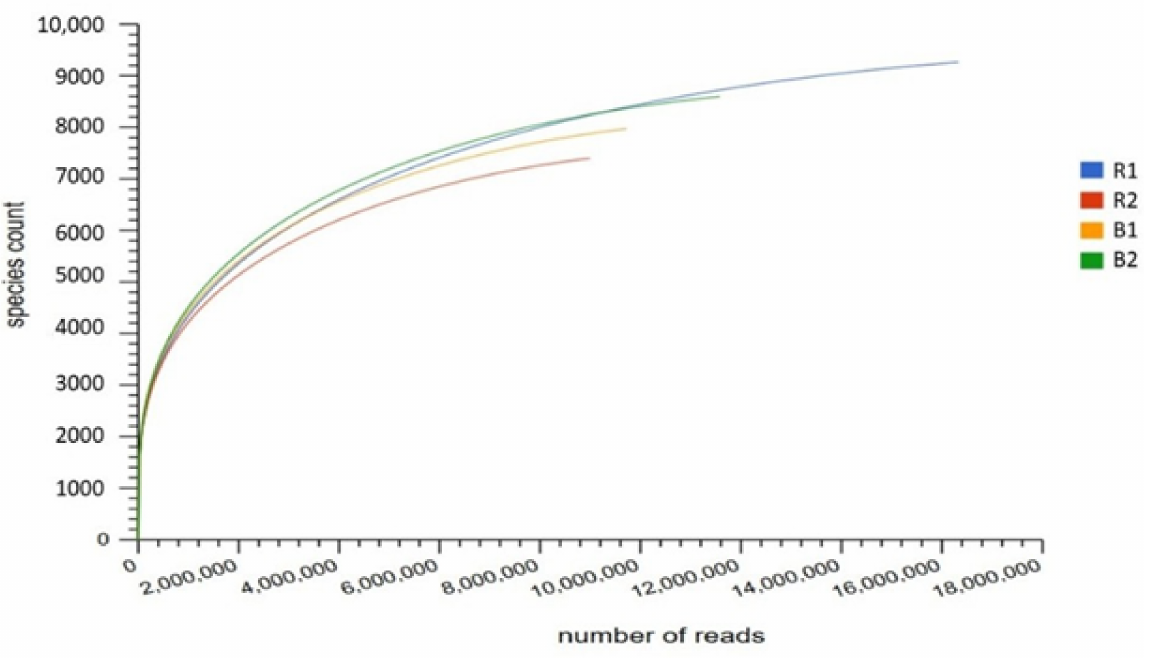
Figure 2. Rarefaction curve showing species richness in the sunflower rhizosphere and its bulk soil samples. The DNA sequencing from the four soil samples (R1, R2, B1, B2) using Illumina technology resulted in a bp count for R1 of 2,388,568,202 bp, sequence count of 13,736,515, mean square length of 174 bp, and mean GC (guanine-cytosine) percentahe of 66. R2 had a bp count of 1,390,678,255, sequence count of 7,559,132, mean square length of 184, and Guanine Cytosine (GC) content of 67. B1 and B2 had bp counts of 1,551,871,377 bp and 1,789,010,308 bp, respectively; sequence count of 8,282,394 and 9,753,315; mean sequence length of 187 bp and 183 bp; and GC content of 66% and 65%, respectively.